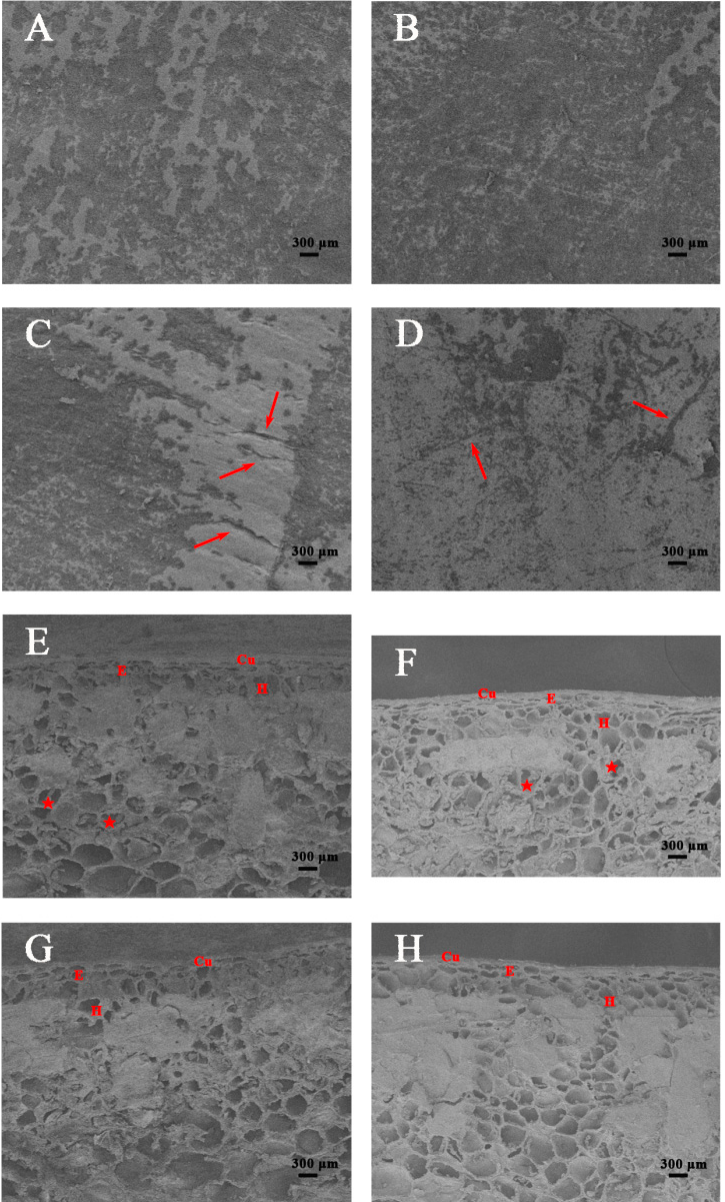
Figure 2. Scanning electron micrographs of fruit peels of two persimmon cultivars during storage. ( A – D ) Fruit surface; ( E – H ) fragments of the cross-sections through the fruit peel; ( A , C , E , G ) “Fupingjianshi”; ( B , D , F , H ) “Ganmaokui”; ( A , B , E , F ) after harvest; ( C , D , G , H ) after 12 days of storage. Cu cuticle, E epidermis, H hypodermis. Amyloplasts (stars) in hypodermal cells. Arrowheads represent microcracks.